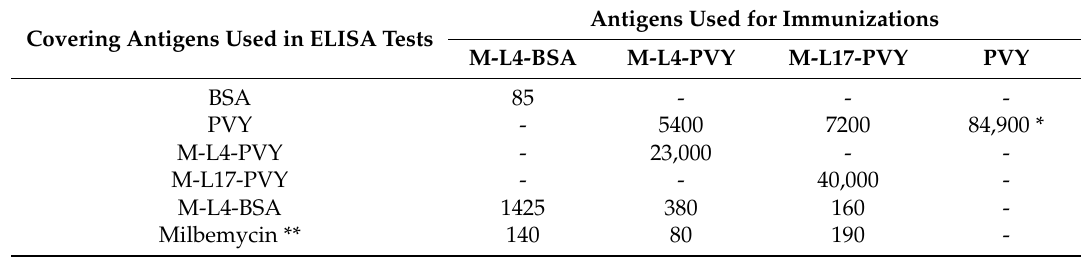
Table 1. Immune responses against different milbemycin conjugates after mice immunization.